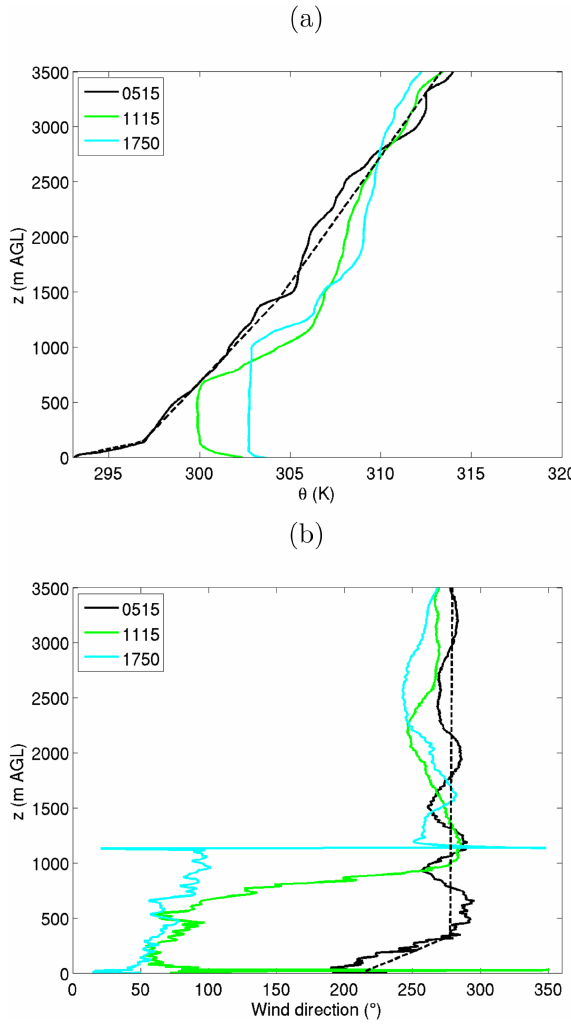
Figure 2. Observed vertical profiles of (a) the potential temperature θ and (b) the wind direction on 20 June 2011. The black dashed lines represent the initial profiles of the